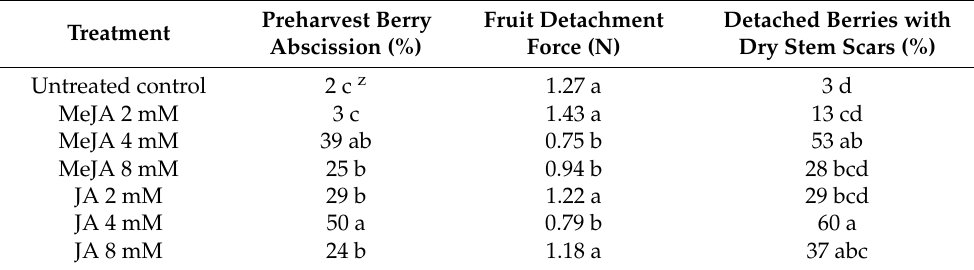
Table 1. The effects of different dosages of methyl jasmonate (MeJA) and jasmonic acid (JA) on preharvest berry abscission, fruit detachment force, and the percentage of detached berries with dry stem scars, 3 days after